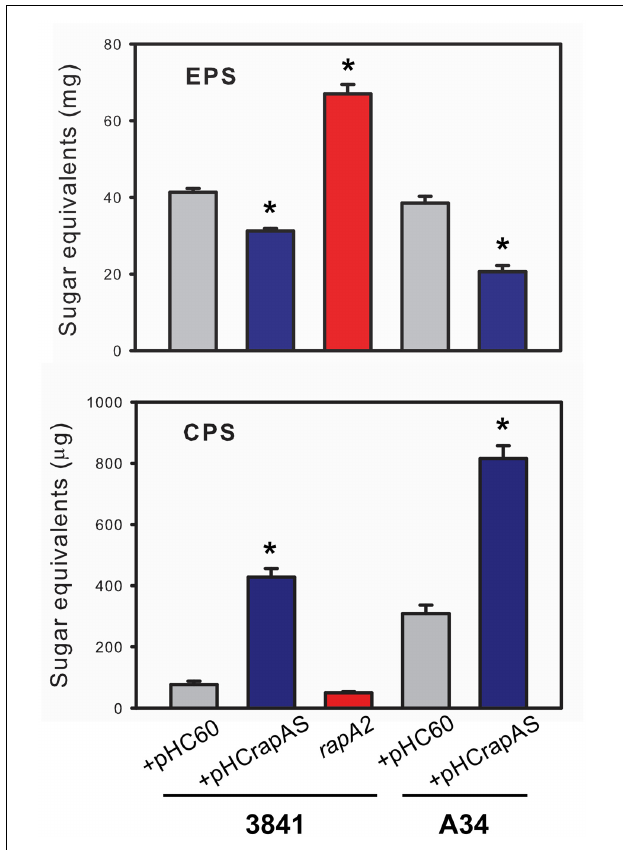
FIGURE 7 | Quantification of EPS and CPS. The EPS and CPS produced by the 3841 and A34 strains and their derivatives were prepared from liquid cultures in Y-minimal medium as described in the text. Quantification was performed by determination of hexoses by the sulfuric acid-anthrone method. The results are representative of two independent experiments that were measured in triplicate each time, with similar results. Data was normalized to mg of cells (fresh weight) and evaluated by ANOVA followed by Turkey post hoc test. (Sigma plot version 11.0, Systat Software Inc., USA). ∗ Significantly different from control ( P <